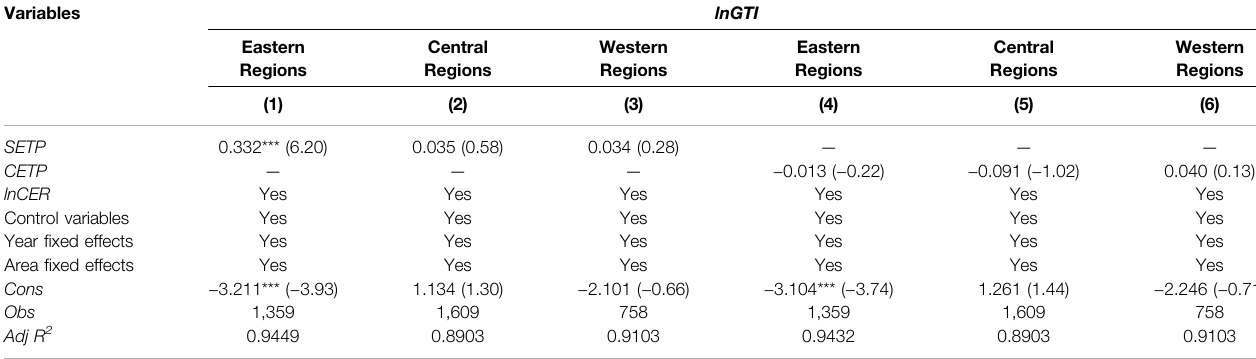
TABLE 5 | Heterogeneity analysis of different regions